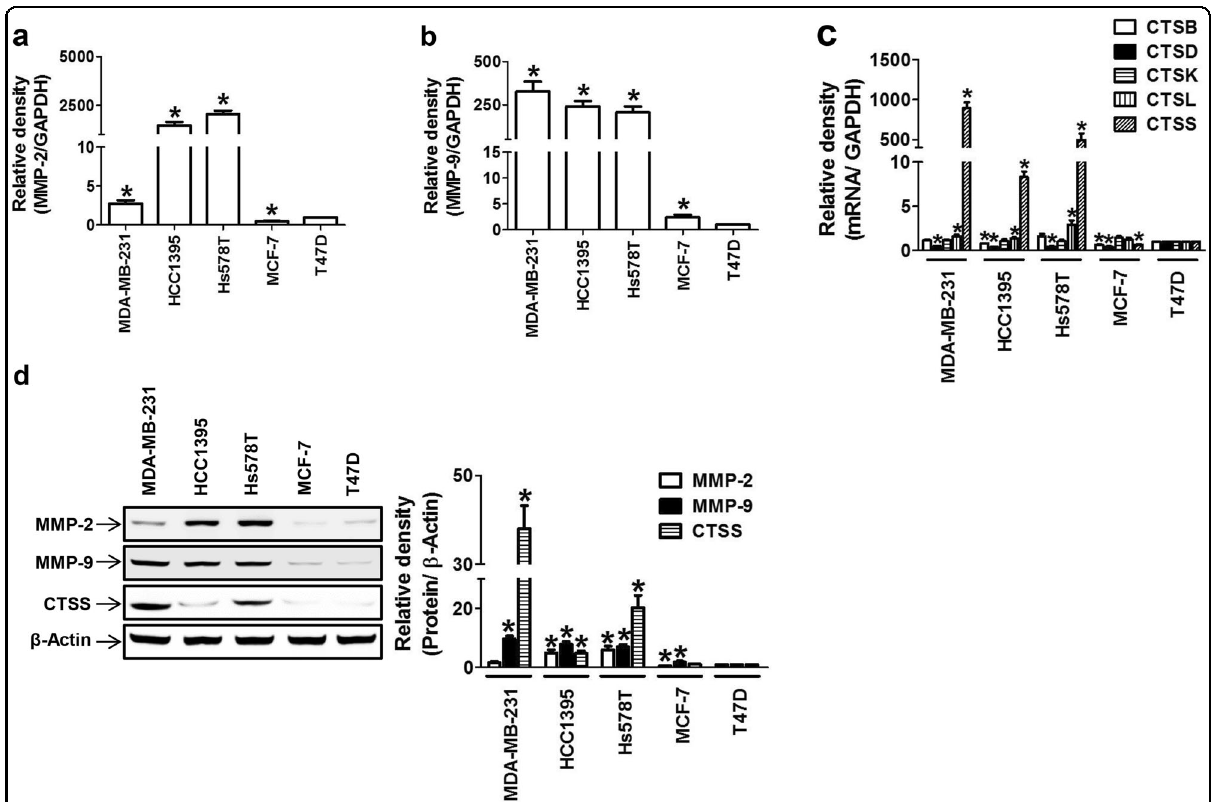
Fig. 1 Relative expression levels of cathepsins and gelatinases in TNBC cells. a – d Basal mRNA expression of MMP -2 ( a ), MMP -9 ( b ), or CTSs ( c ) and their protein expression ( d ) in multiple breast cancer cell lines (MDA-MB-231, HCC-1395, Hs578T, MCF-7, and T47D). The bar-diagram represents the quantitation of the gene expression, * P < 0.05 compared to T47D